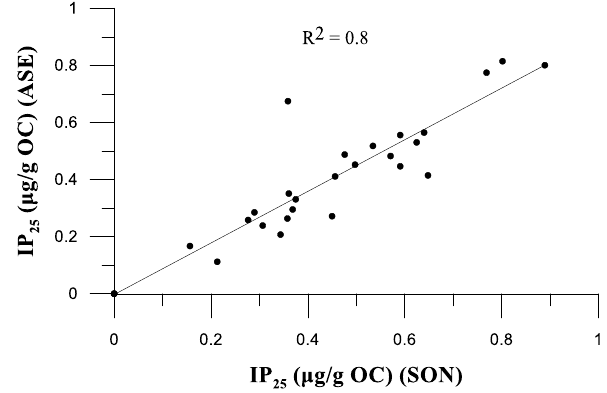
Fig. 5. Comparison of IP 25 concentration data obtained following extraction of sediment material using Accelerated Solvent Extrac- tion (ASE) and sonication (SON) methods. Concentrations have been normalised to total organic carbon (TOC) in each case.